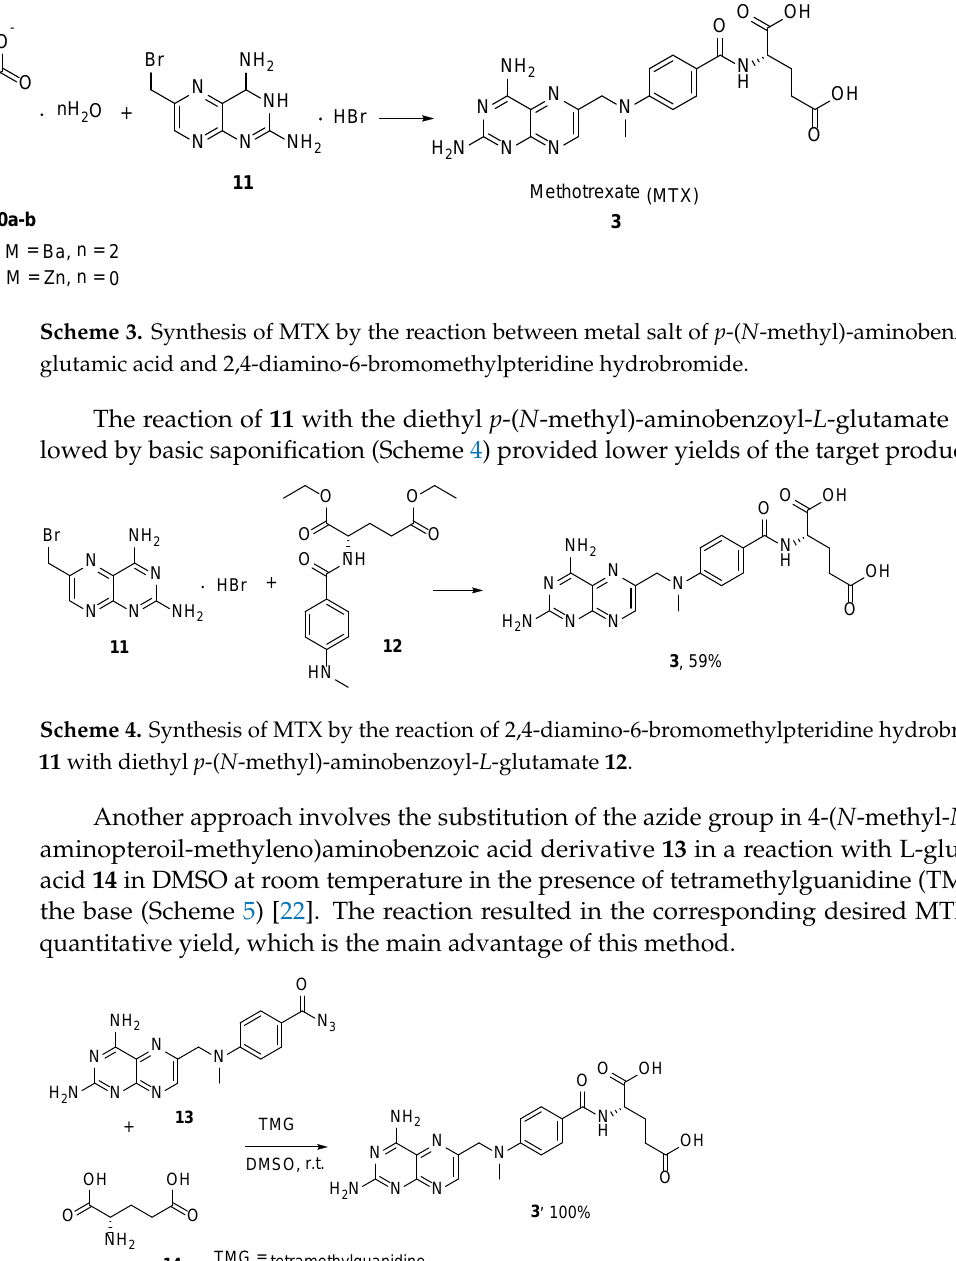
Scheme 5. Quantitative synthesis of MTX by the reaction of 4-( N -methyl- N ′ -(6 ″ -aminopteroil-meth- yleno)aminobenzoic acid derivative 13 with L-glutamic acid 14 .